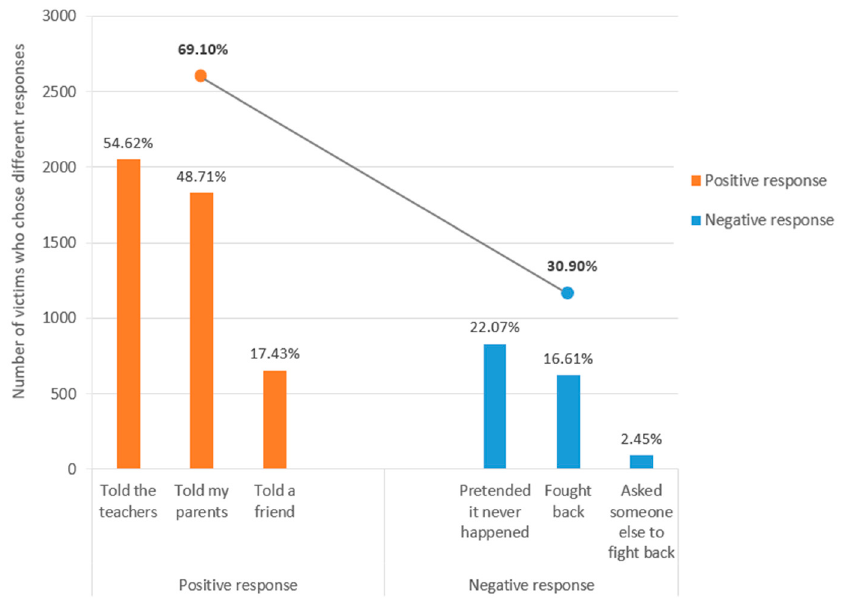
Figure 1. Victims’ responses to school bullying in primary schools of Luzhou City.